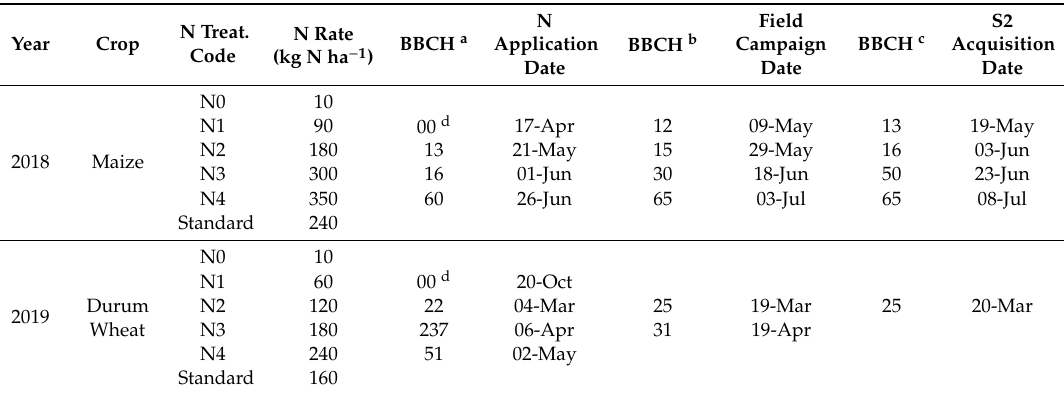
Table 2. Experimental design